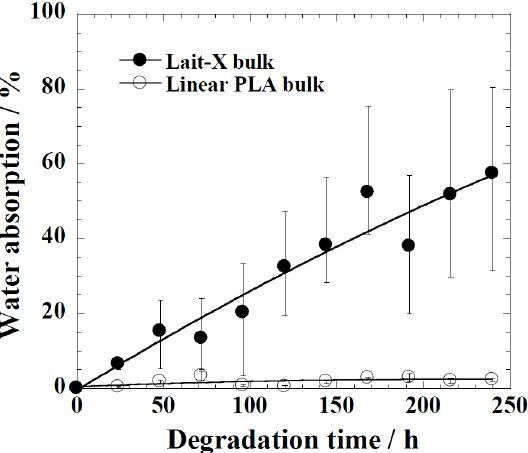
Figure 8. Water absorption changes of Lait-X bulk ( A / V = 1.5 mm − 1 ) and linear polylactide (PLA) ( A / V = 2.6 mm − 1 ) during the enzymatic degradation at 37